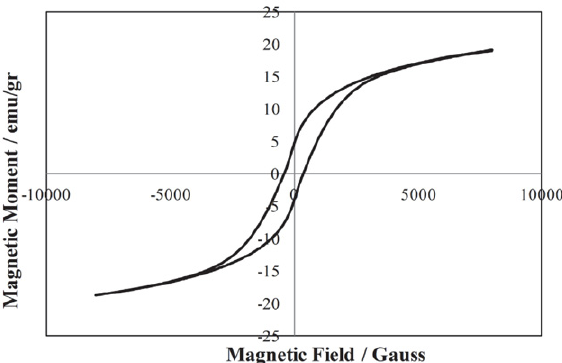
Figure 4. Hysteresis loop of AlCoFe 2 O 4 nanoparticles